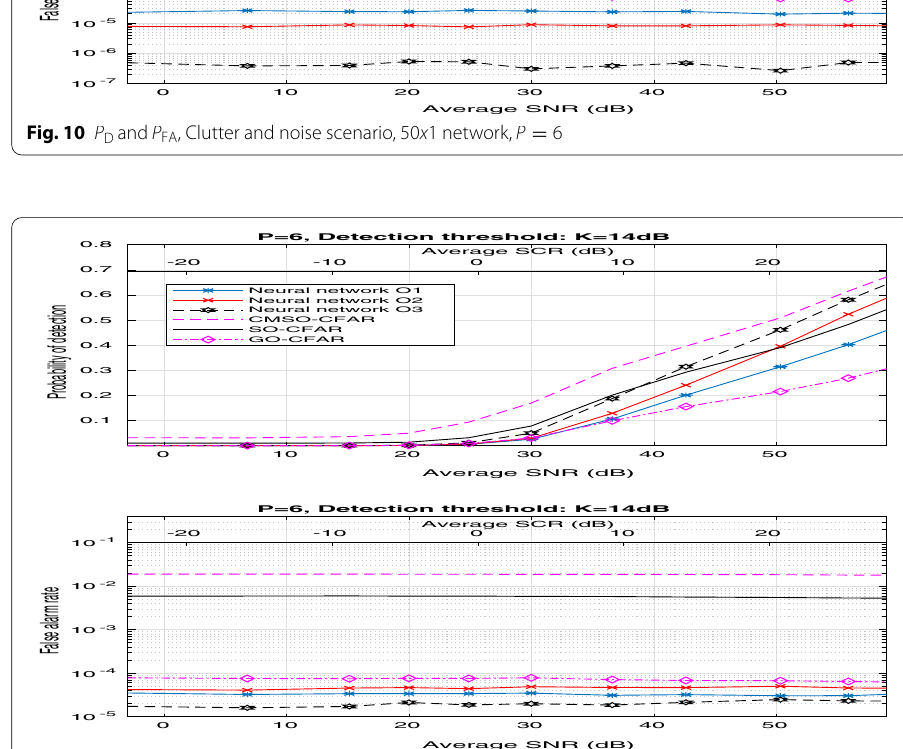
Fig. 11 P D and P FA , Clutter and noise scenario, 50 x 2 network, P =